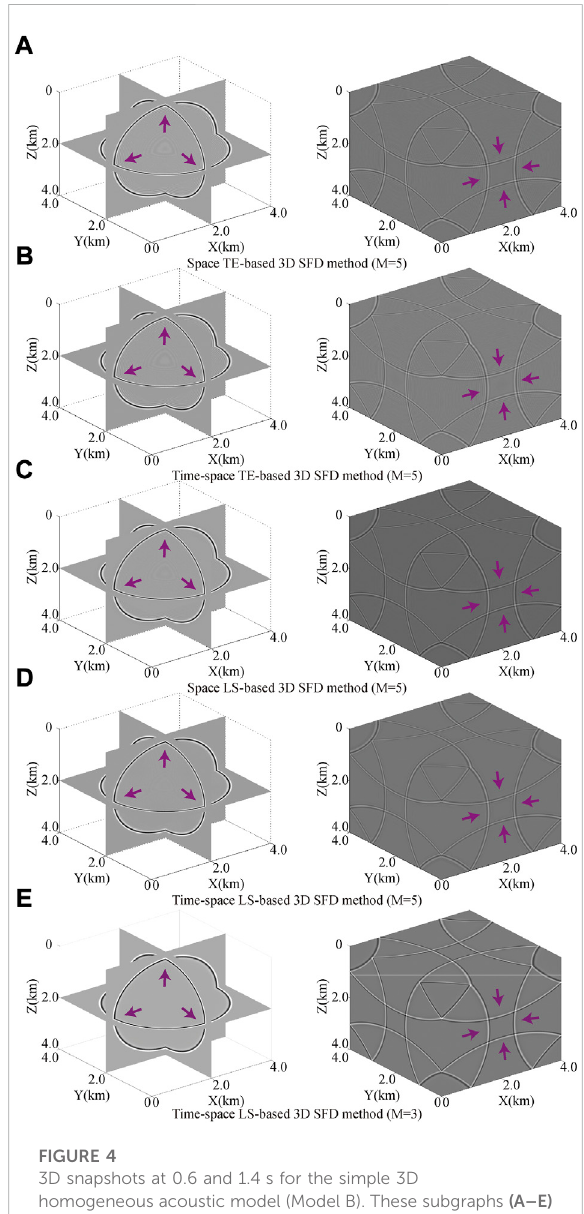
FIGURE 4 3D snapshots at 0.6 and 1.4 s for the simple 3D homogeneous acoustic model (Model B). These subgraphs (A – E) indicate different 3D SFD methods with different difference operator lengths ( M (cid:2) 3 and M (cid:2) 5) listed in